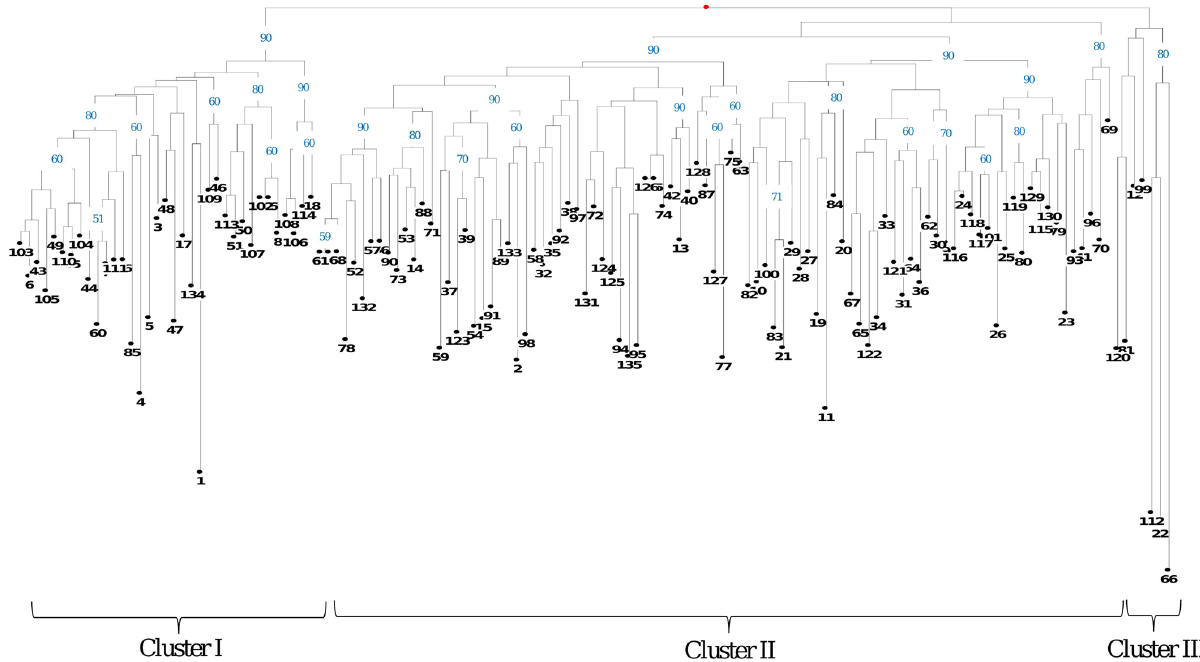
Figure 6. Cluster analysis: Neighbour-joining tree based on genetic distances of 135 tea cultivars using 15 polymorphic TF-SSR markers. Numbers above branches indicate bootstrap values ≥ 50% (1000 bootstrap